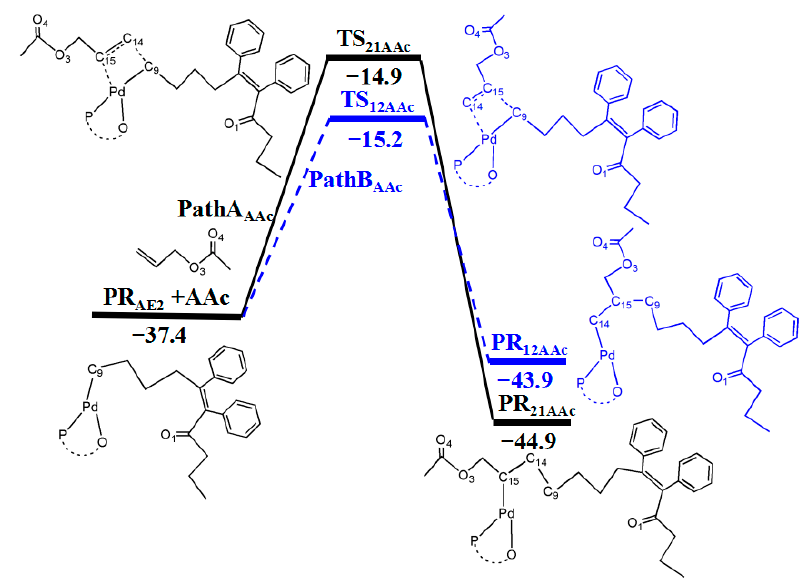
Figure 11. The reaction pathway of the allyl acetate (AAc) insertion, Path A AAc (black) and Path B AAc (blue); the relative free energy is given in kcal/mol.